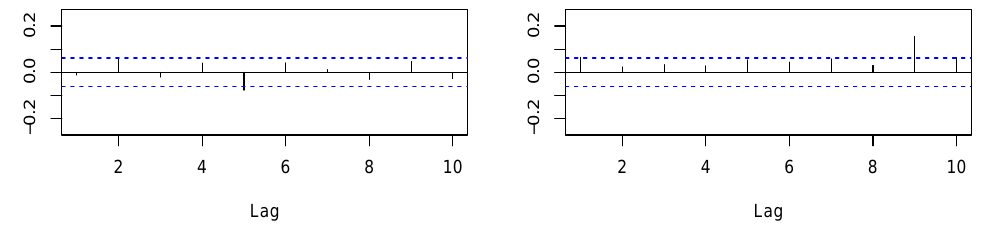
Figure 6. (cid:98) w t , in-sample autocorrelations of HAR residuals ( left ) and their squares ( right